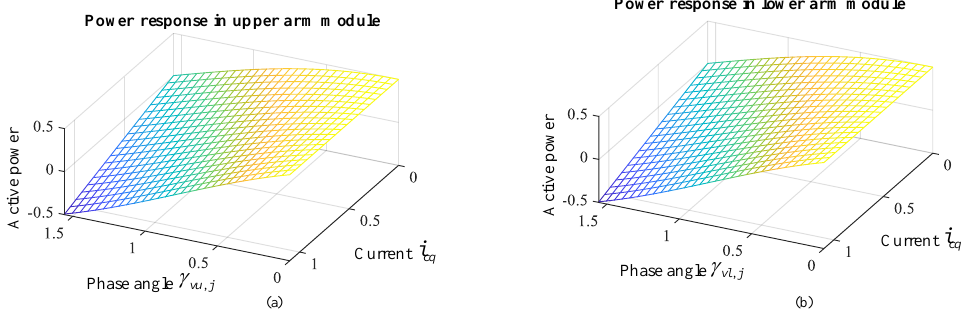
Figure 5. Active power compensation under circulating current and phase-angle variations with equal power distribution. ( a ) Module in the upper arm, ( b ) module in the lower arm.